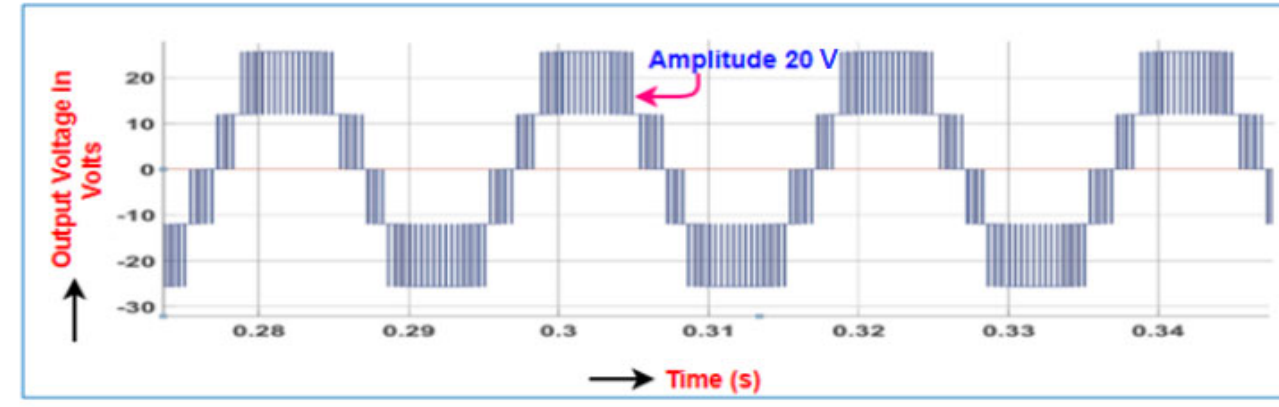
Figure 21. CMV of reduced switch multilevel inverter using SPWM.